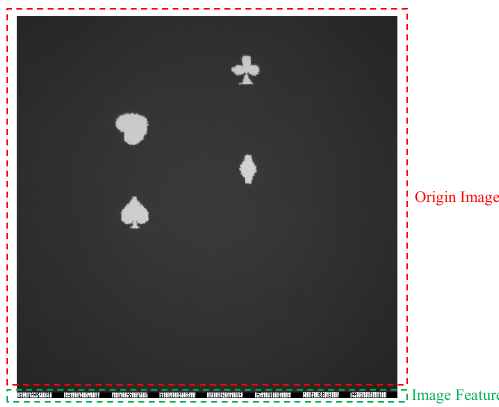
Figure 12. Sample of the captured frame.